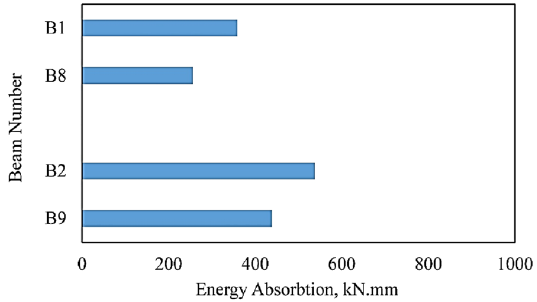
Fig. 19 Energy absorption for beams B1, B2, B8, and B9